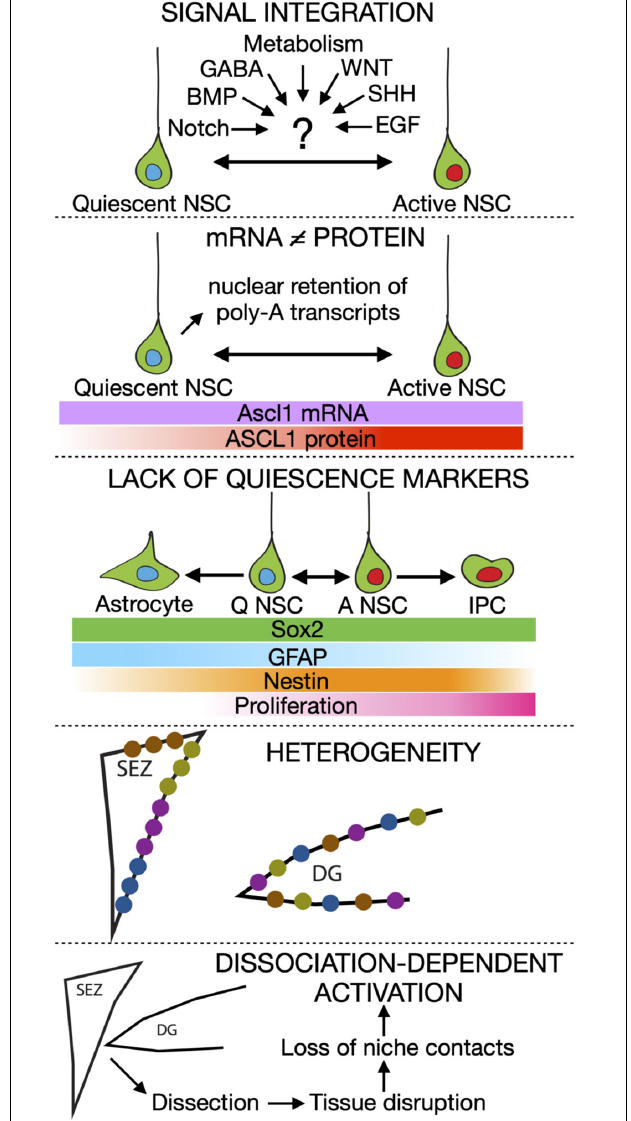
FIGURE 1 | Summary of the current roadblocks in our understanding of adult neural stem cell activation. IPC, Intermediate progenitor